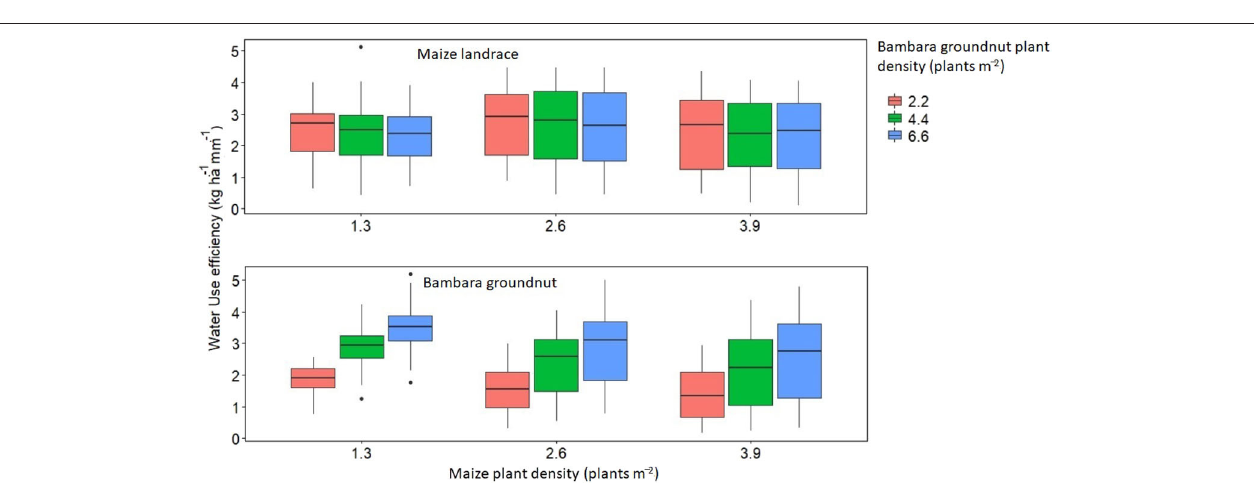
FIGURE 9 | Calculated water use efficiency maize landrace and bambara groundnut plant population (plant m − 2 ) for climate scenarios obtained from six GCM (ACC, CSS, CNR, GFD, NOR, and MPI). The colored boxplots represent the bambara groundnut plant density (plant m − 2 ). The effect of maize landrace plant density on maize landrace WUE - F -statistic: 6.78 on 2 and 891 DF, P = 0.001. The effect of the interaction between maize landrace plant density and bambara groundnut plant density on bambara groundnut WUE - F -statistic: 38.93 on 24 and 875 DF, P =